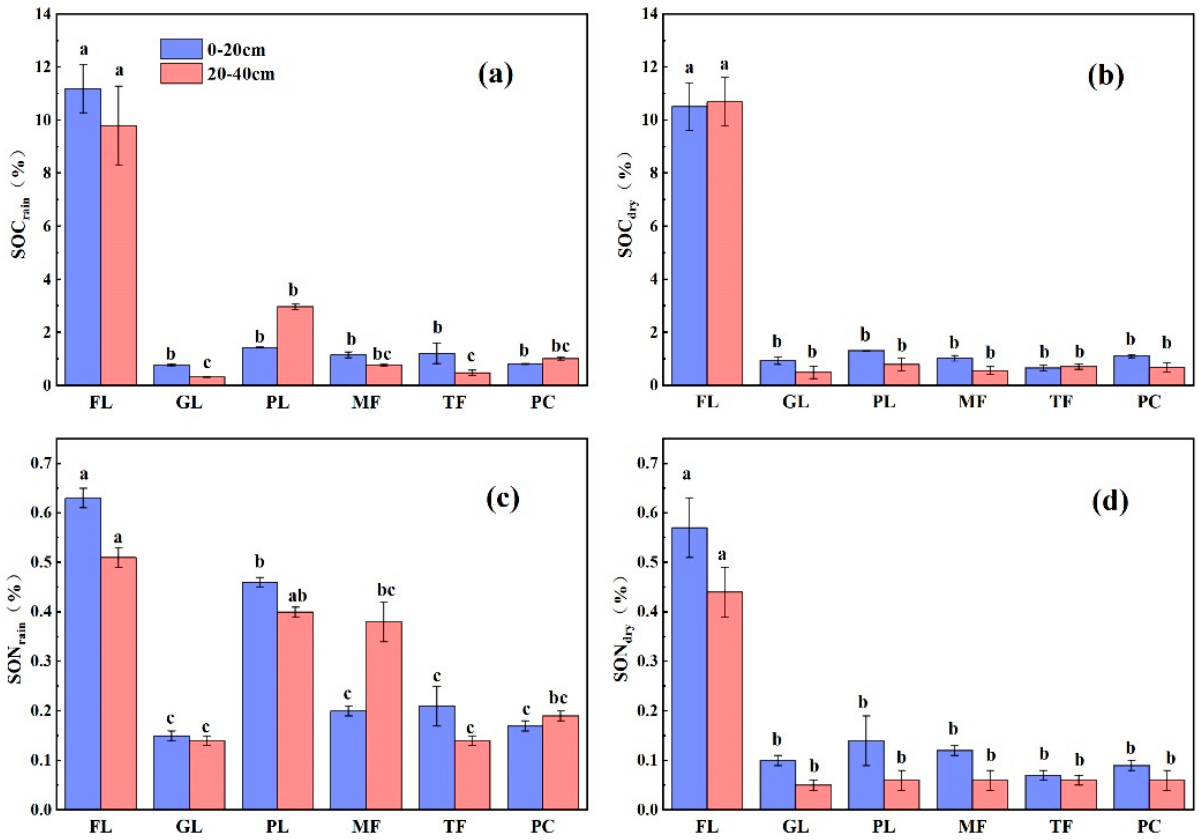
Figure 1 . Average contents of SOC and SON in the 0–20 cm and 20–40 cm soil layers of the six land use types in the rainy and dry seasons. (a) SOC rain , rainfed soil organic carbon; (b) SOC dry , dry-season soil organic carbon; (c) SON rain , rainfed soil organic nitrogen; (d) SON dry , dry-season soil organic nitrogen. Forest land: FL; peach: PC; paddy land: PL; tobacco field: TF; maize field: MF; and grass- land: GL. Different lowercase letters indicate significant differences in SOC content (SON) between land types in the same soil layer at the P < 0.05 level.